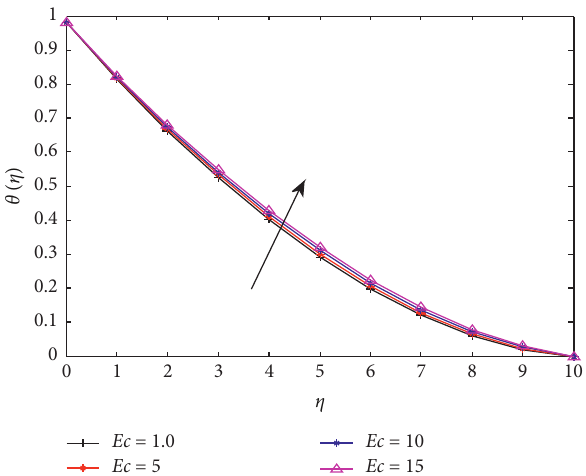
Figure 12: Temperature profile for altered values of Ec when Pr � 0 . 72, β � 0 . 2, Ω � M � λ � R � s � 1, and c � 0 .